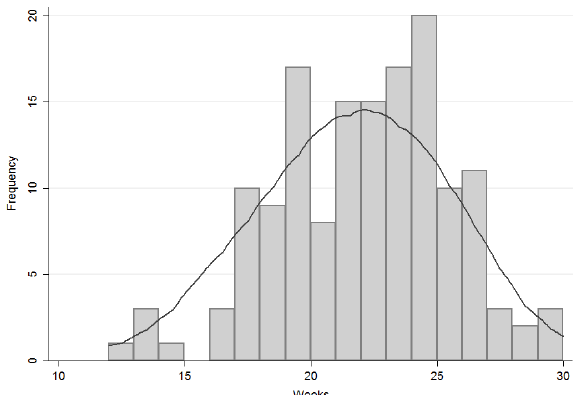
Figure 1. Distribution curve of the timing of first introduction of complementary foods in weeks.